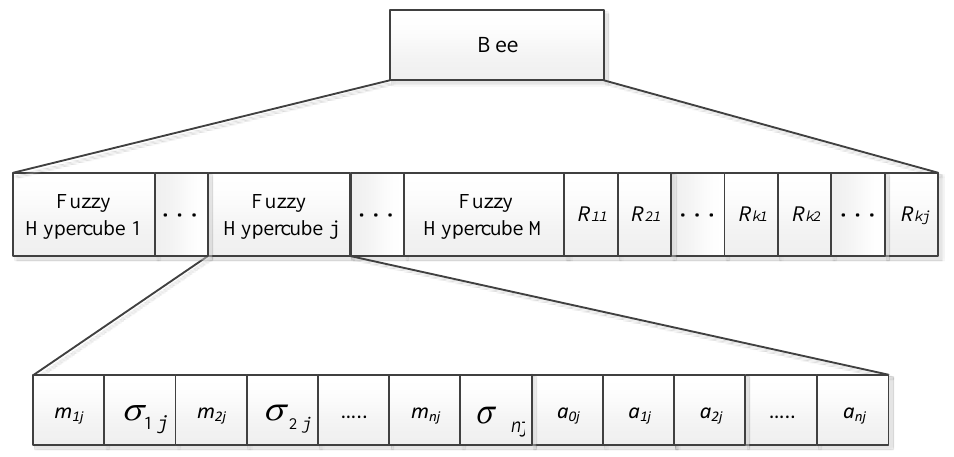
Figure 10. Schematic of individual bees.